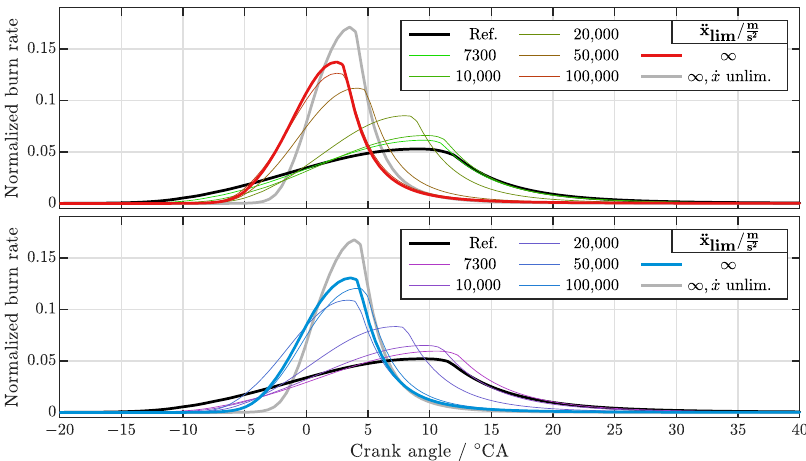
Figure 12. Heat release rates for the optimized piston trajectories at full ( top ) and part ( bottom ) load operation for different maximum piston acceleration limits.